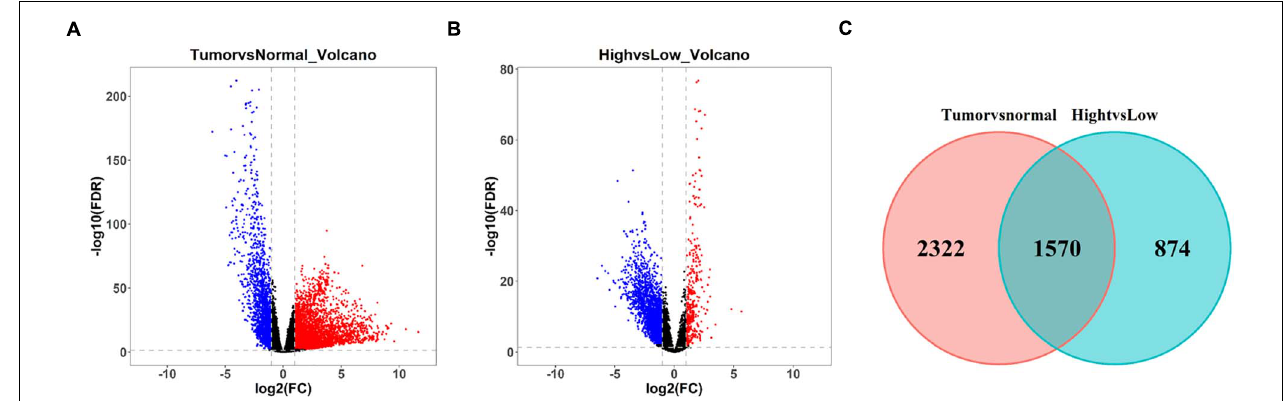
FIGURE 4 | Screening of differentially expressed lncRNAs related to immune infiltration in LUAD. (A) Volcano plot of differential expression analysis of lncRNAs in LUAD tissue and normal tissue. Blue dots represent downregulated lncRNAs and red dots represent upregulated lncRNAs (| logFC| > 1, FDR < 0.01). (B) Volcano plot of differential expression analysis of lncRNAs in LUAD tissue in Immunity_H and Immunity_L groups. Blue dots represent downregulated lncRNAs and red dots represent upregulated lncRNAs (| logFC| > 1, FDR < 0.01). (C) Venn diagram of differential lncRNAs related to LUAD occurrence in panel (A) (red circle) and differential lncRNAs related to immune infiltration in panel (B) (green circle).